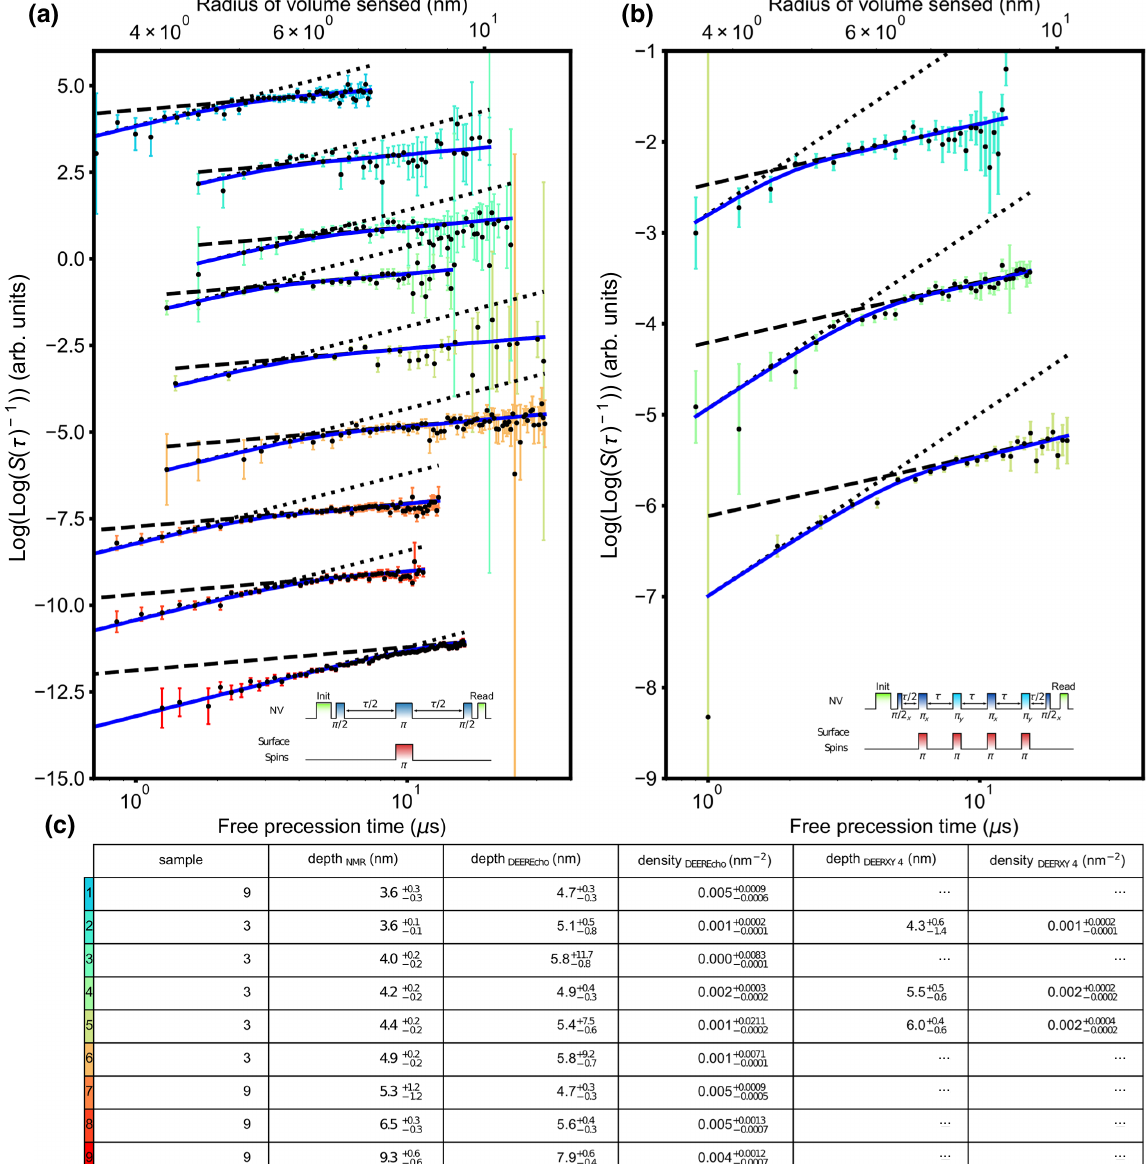
FIG. 16. Additional NV center measurements. (a) Plots of log S (τ) − 1 for nine additional NV centers. Inset: pulse sequence used to measure NV centers in (a). Blue lines are fits to the hopping model in the main text, and dotted and dashed lines show slopes of 2 and 2/3, respectively. The y -axis offset is arbitrary. (b) DEER XY-4 data for three of the nine additional NV centers, plotted as in (a). Inset: DEER XY-4 pulse sequence. (c) Surface spin densities and depths extracted from NV centers in (a) and (b). Here Depth the NV center depth extracted from fitting the proton NMR signal, while Depth the hopping model in the main text. Error bars are one standard